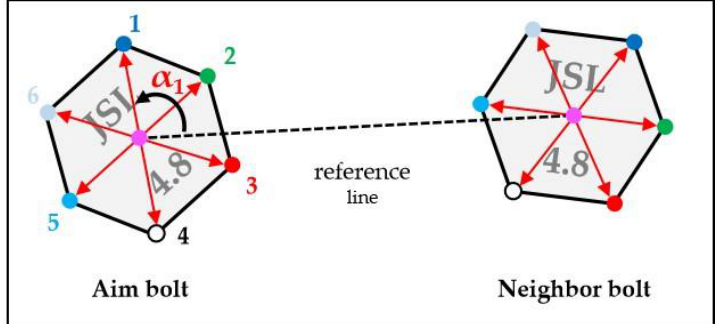
12 of 22 Figure 12. The result of key-point marking and recognition box generation.